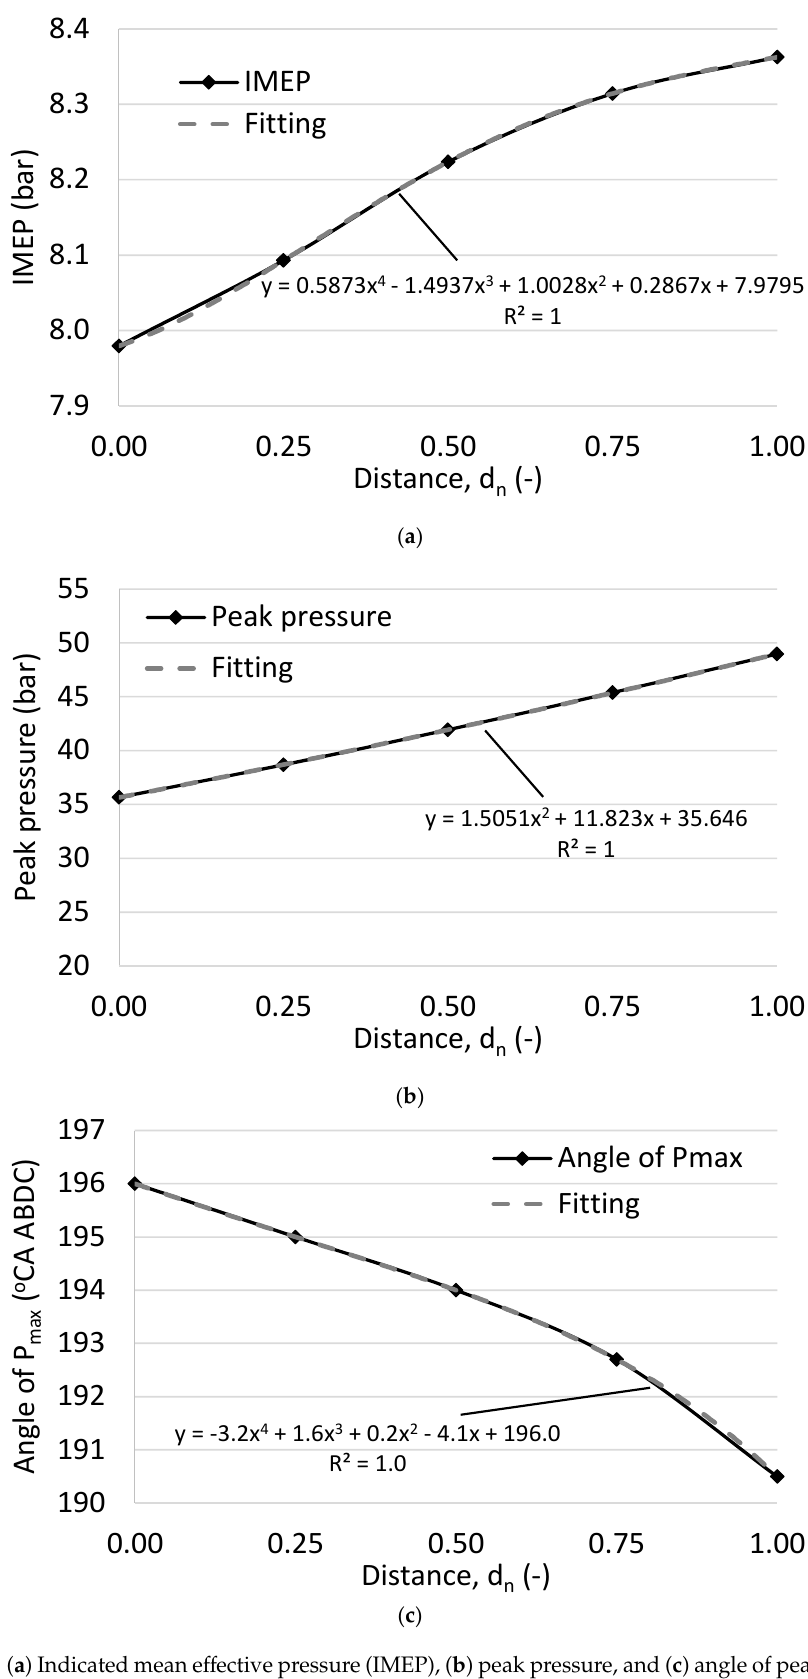
Figure 2. ( a ) Indicated mean effective pressure (IMEP), ( b ) peak pressure, and ( c ) angle of peak pressure for the five representative cycles with a different d n value. Their fitted correlations are also shown, together with the R 2 .